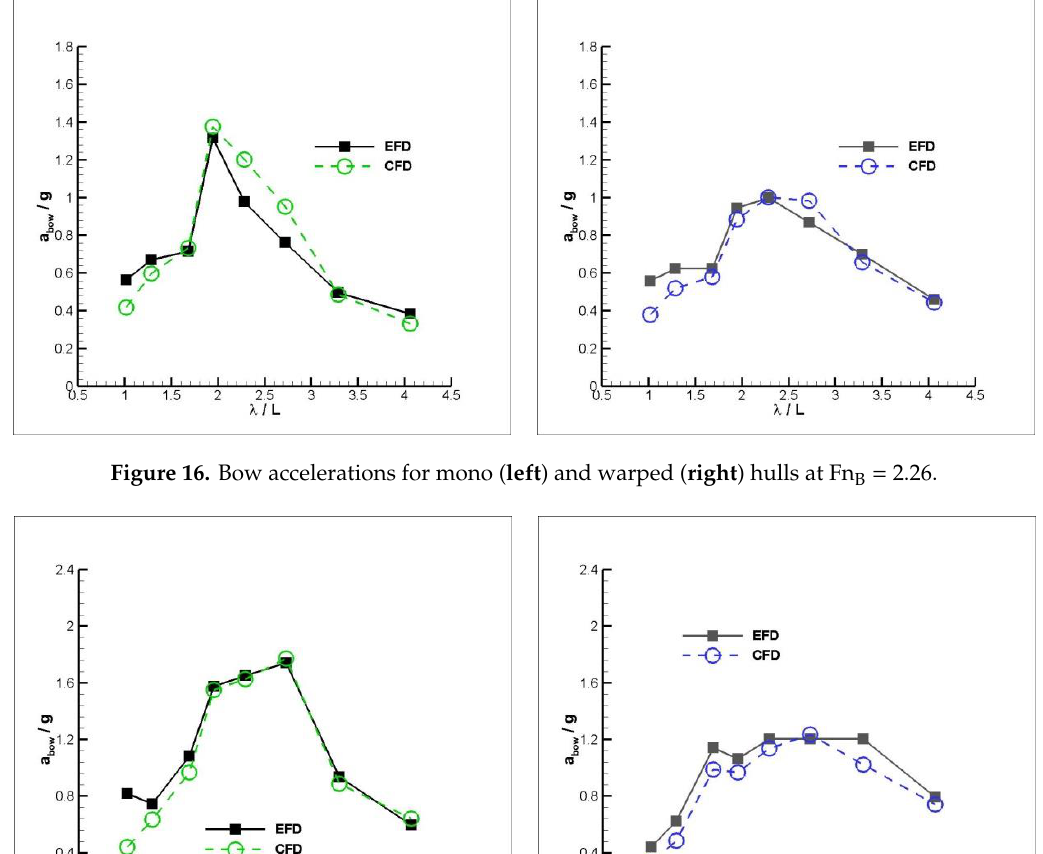
Figure 15. Bow accelerations for mono ( left ) and warped ( right ) hulls at Fn B = 1.67.